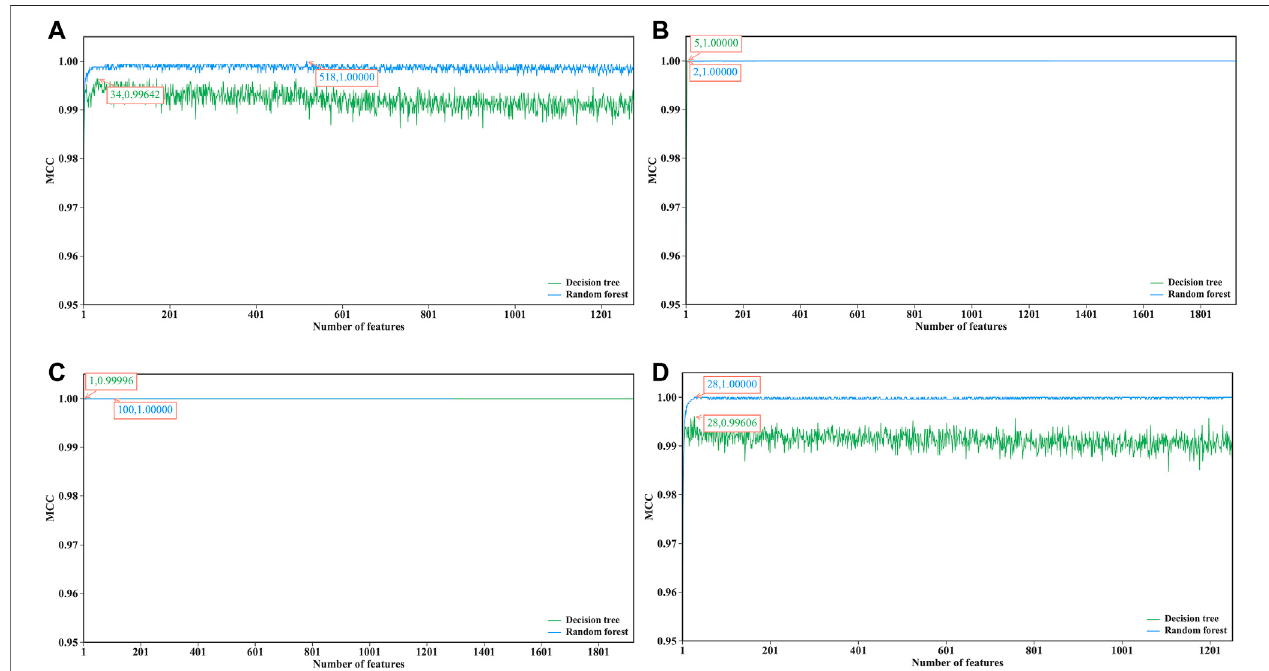
FIGURE2| IFScurvesofdecision treeand random forest ondatasets offour cerebellumcell types. (A) Curves on dataset forGolgicells, (B) Curves on dataset for Granule cells, (C) Curves on datasets for Interneuron cells, (D) Curves on dataset on Unipolar brush cells.